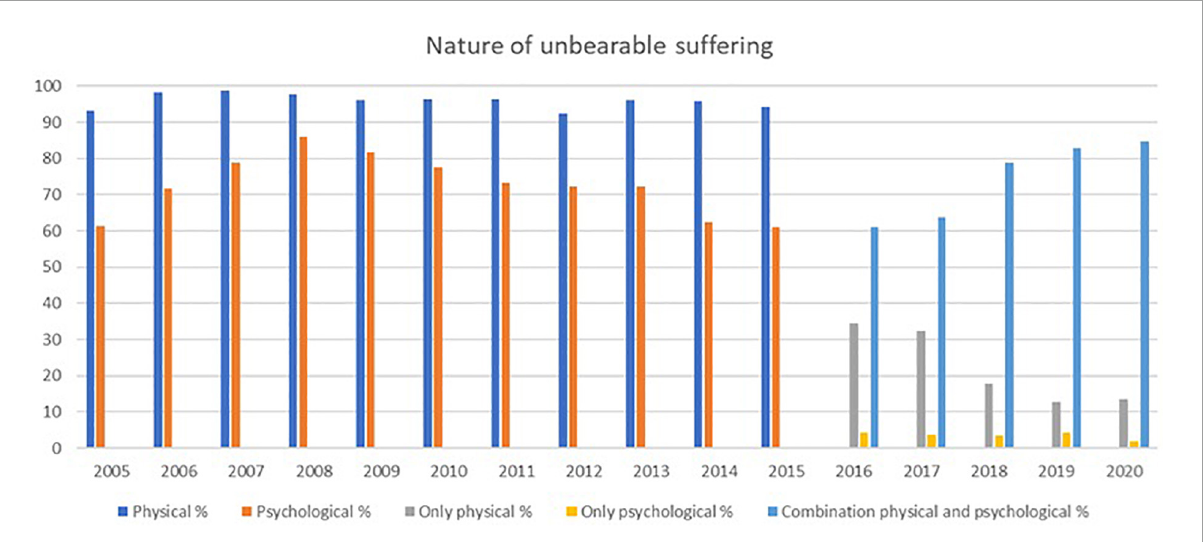
FIGURE3 Nature of unbearable suffering (from the official reports of the FCECE)*. *Category of labels changed between 2015 and